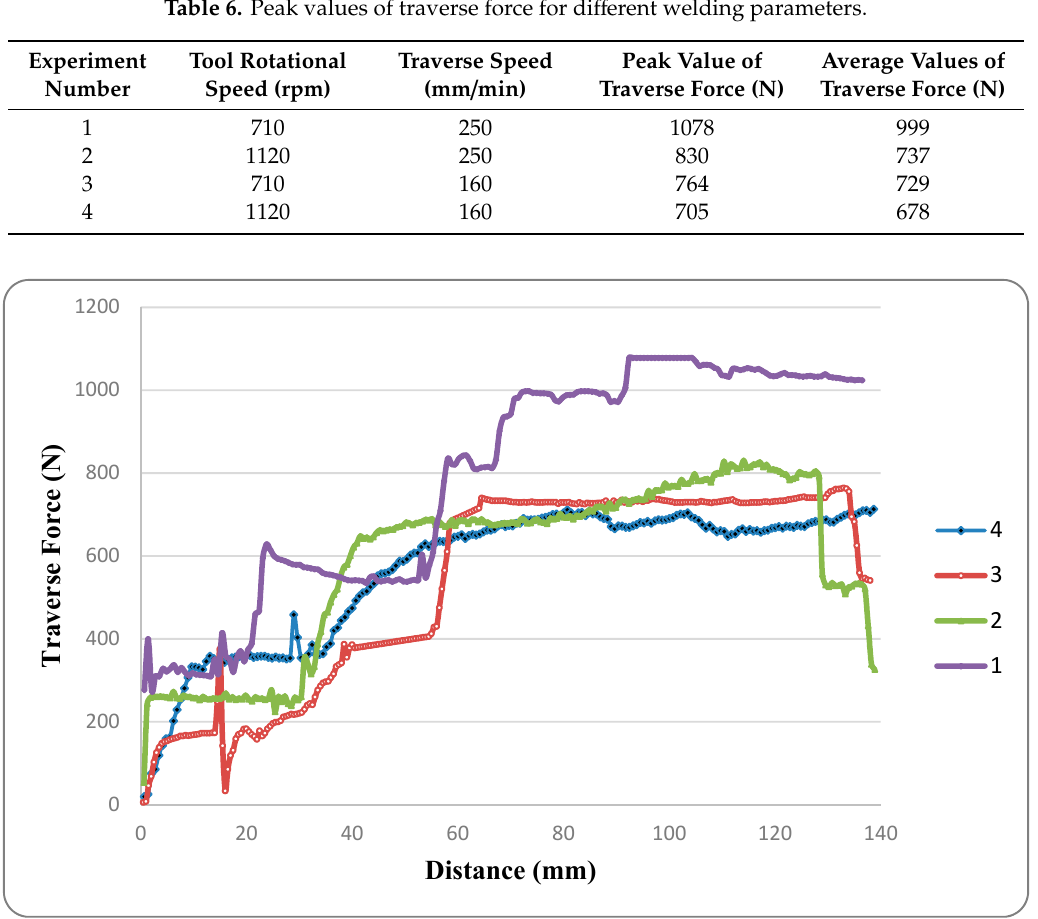
Figure 4. Traverse force exerted on the tool pin vs. distance travelled by the friction stir welding (FSW) tool for Experiments 1–4.